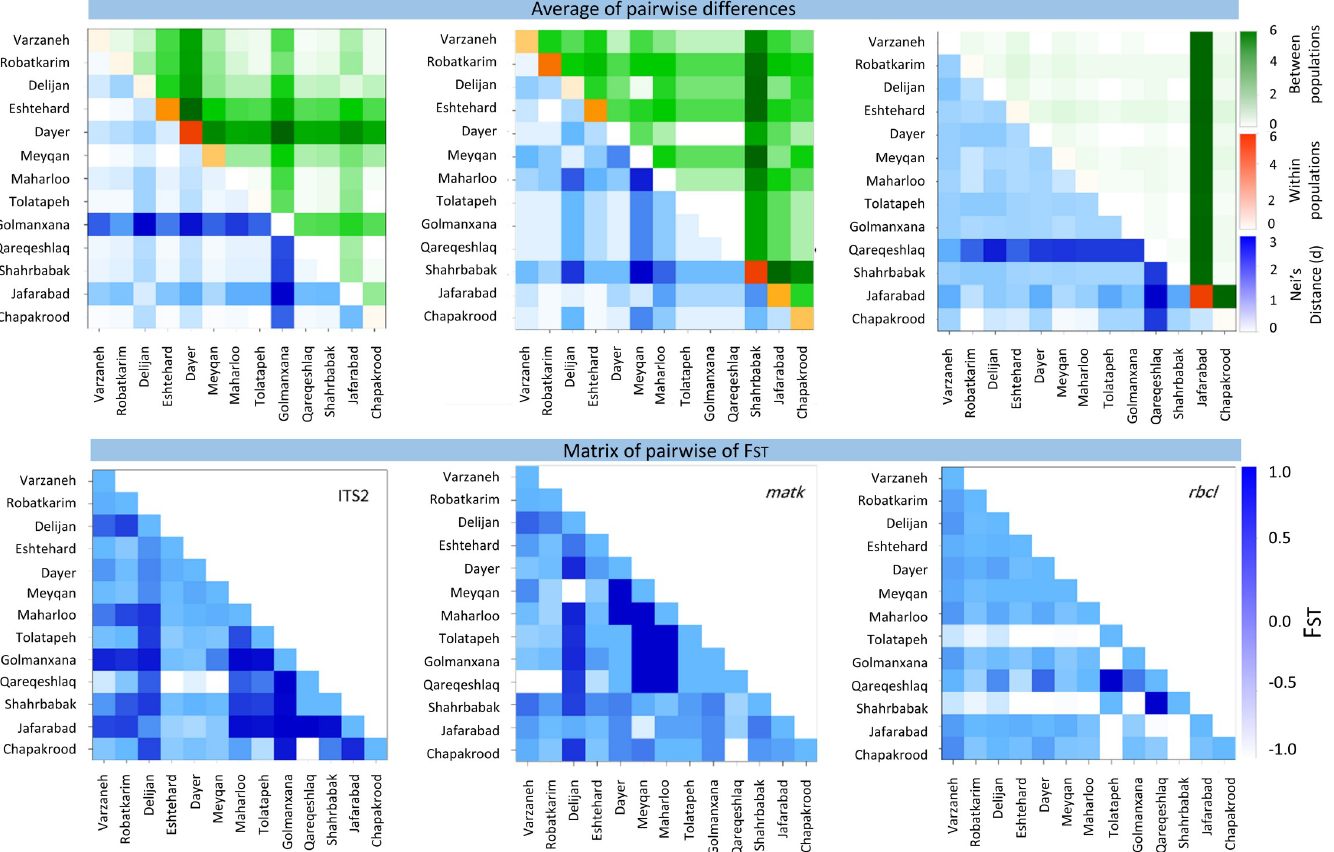
index in Salicornia germplasm in Iran, based on plastid and nuclear markers. st